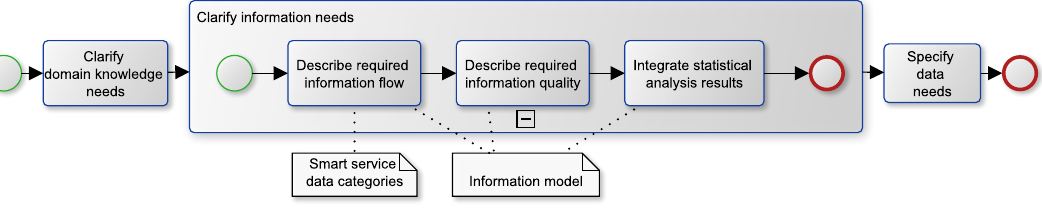
Figure 6. Process steps to clarify information